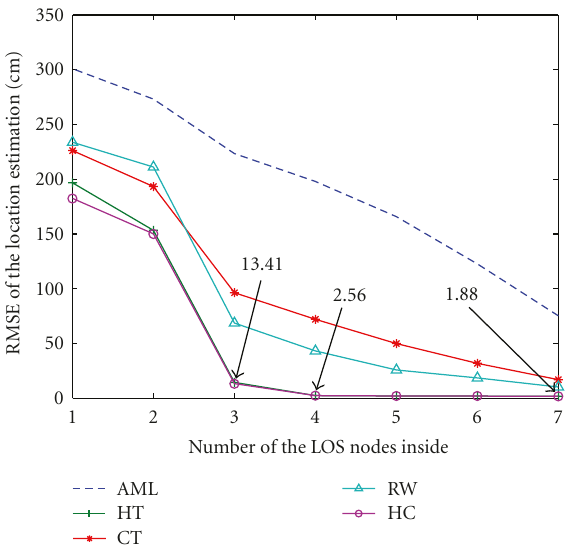
Figure 6: Performance of the methods depending on the number of LOS reference nodes. The network consists of eight reference nodes. 1000 trials have been averaged.